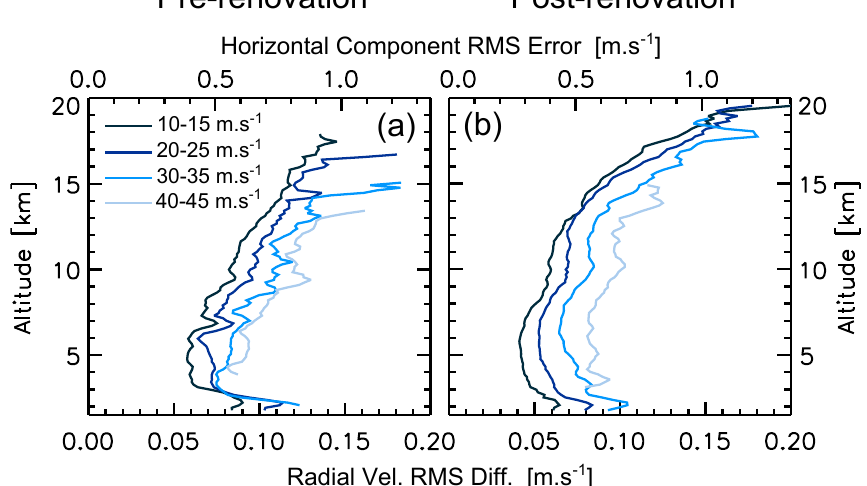
Figure 10. Radial velocity RMS differences at different horizontal wind speeds, before and after the renovation (panels (a) and (b) , re- spectively). RMS values are from the difference of vertical beam and complementary beam vertical velocities, normalised to indicate the error associated with measurements made on a single beam (see text). Different shaded curves correspond to the different horizontal wind speeds described in the legend. The curves are averages of both 6 ◦ zenith beam pairs. Pre-renovation and post-renovation curves use all wind directions in 2010 and 2012, respectively. The top axis gives the corresponding RMSE in horizontal wind components.